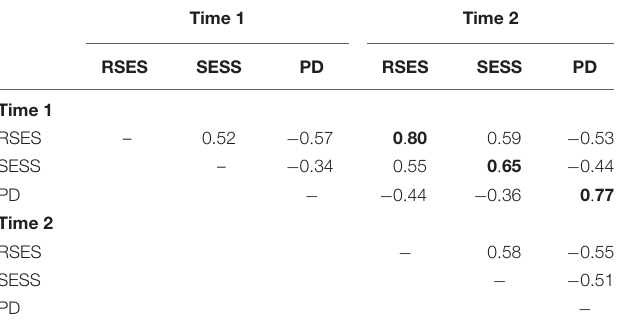
TABLE 2 | Intercorrelation of scores from Time 1 and Time